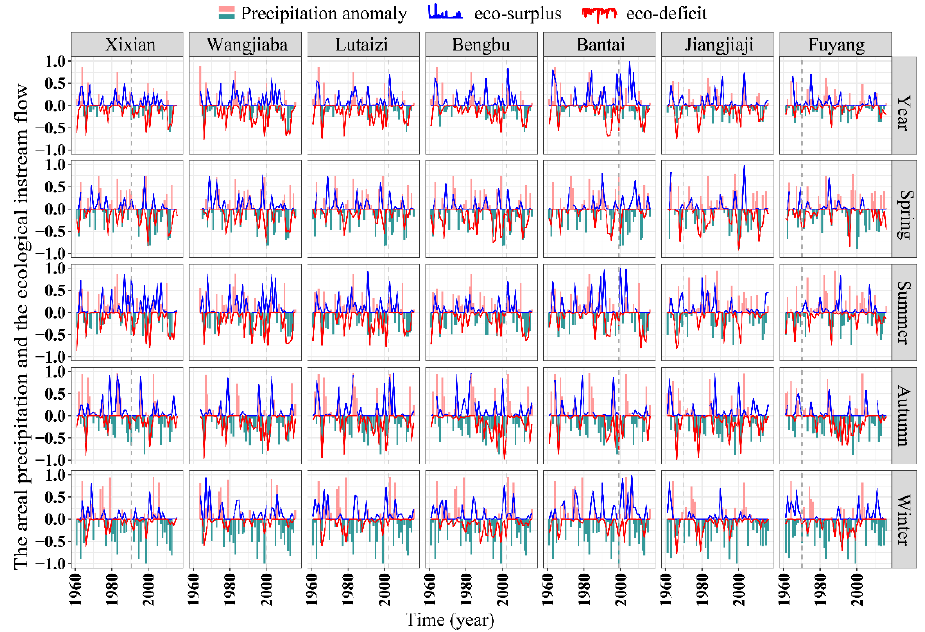
Figure 5. Temporal variations of the difference of the area precipitation and the ecological instream flow across the HRB.